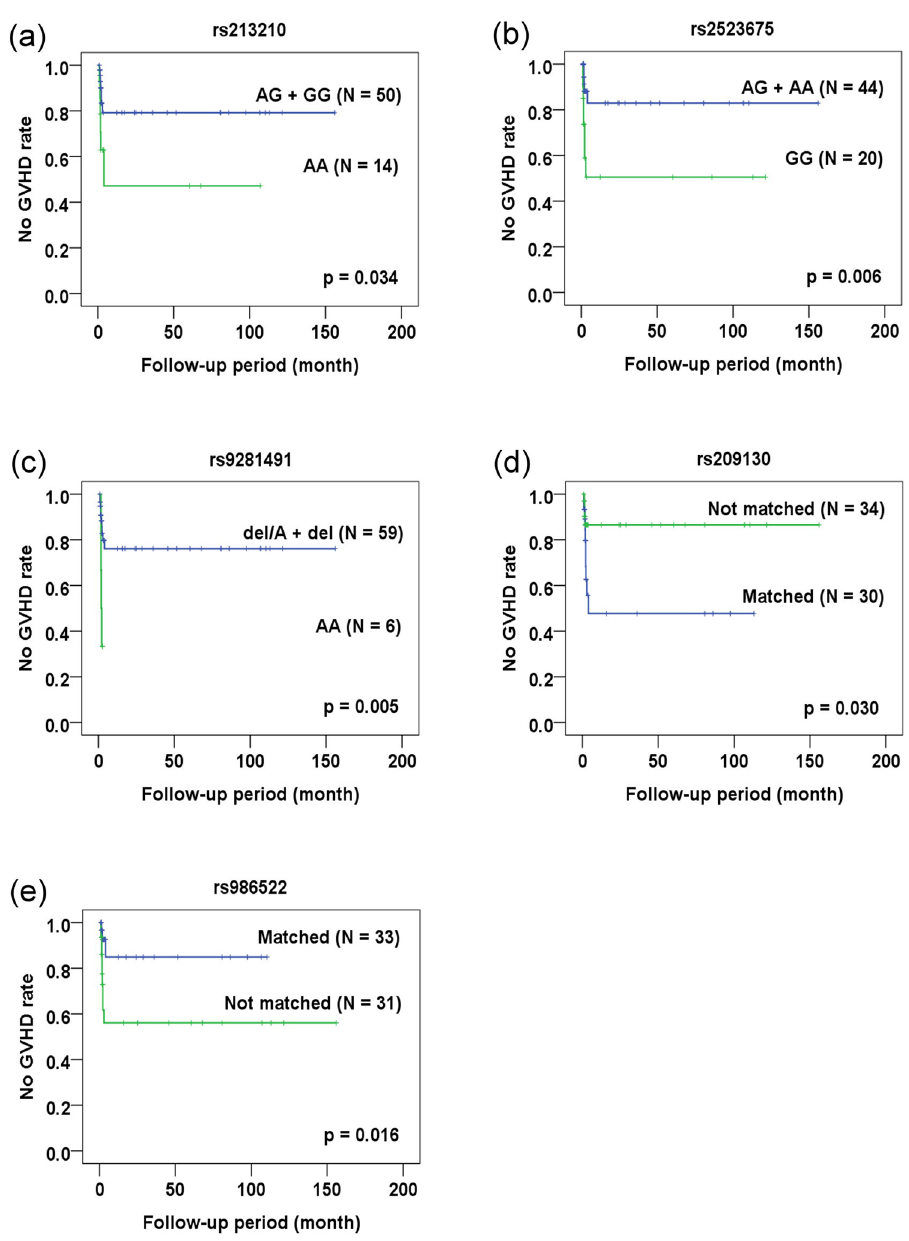
Figure 2. Kaplan–Meier analysis of severe GVHD-free duration. ( a – e ) Severe GVHD-related SNPs as revealed by end-point analysis were subject to Kaplan–Meier analysis. The severe GVHD-free status for the SNPs with the indicated genotypes (panels a – c ) or matched vs. not matched status for the donor and recipient genotypes (panels d , e ) was plotted against the follow-up period (month) after